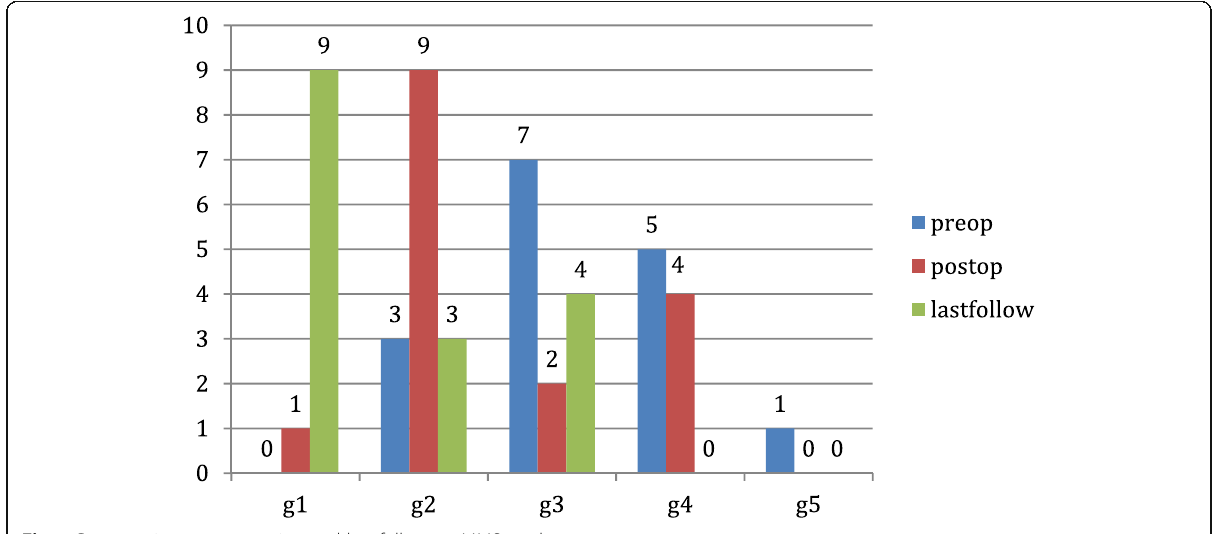
Fig. 1 Preoperative, post-operative, and last follow-up MMS grades